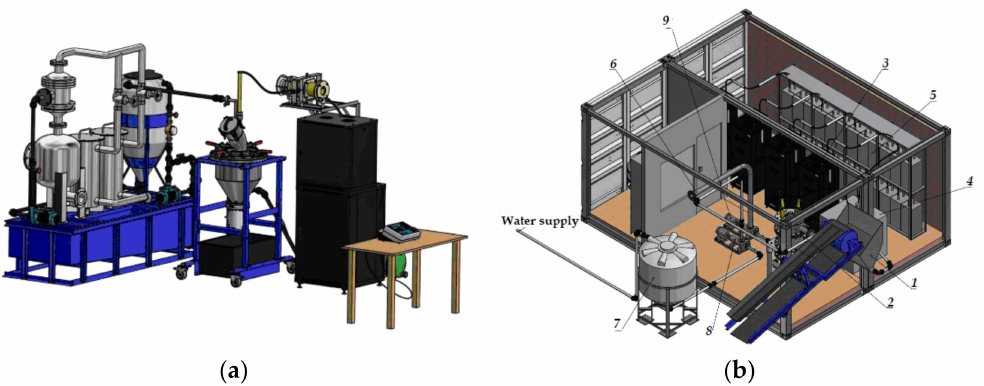
Figure 2. Electrohydraulic installations of the ElectroHydroDynamika Group (St. Petersburg, Russia): ( a ) laboratory installation EGDL-10 and ( b ) industrial modular installation EGD-10 [79]: 1 —feed unit, 2 —reactor, 3 —pulse current generators, 4 —air discharger, 5 —capacitor unit, 6 —material sampling unit, 7 —water buffer tank, 8 —water supply pump, 9 —slurry pump. Reprinted with permission